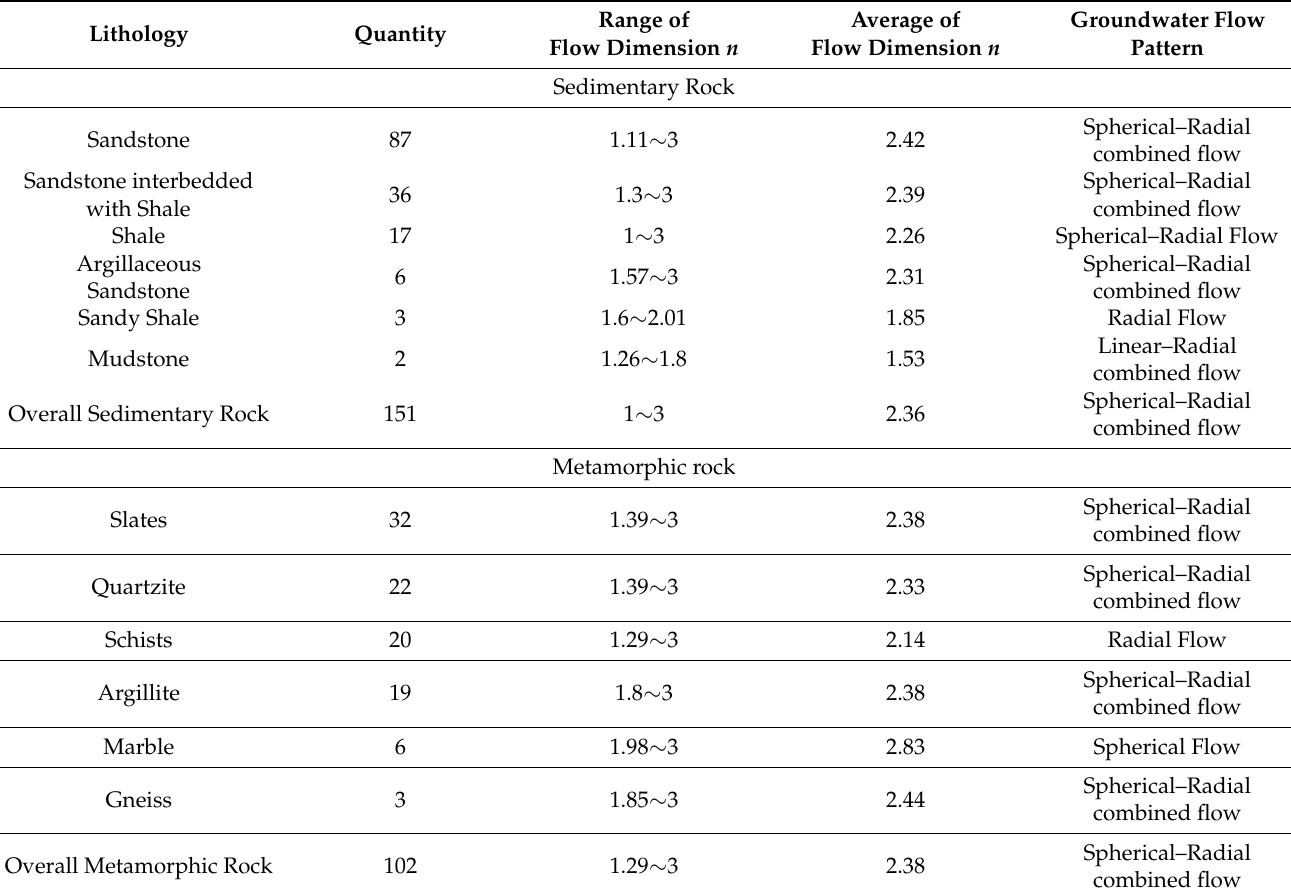
Table 8. Flow dimension n for various